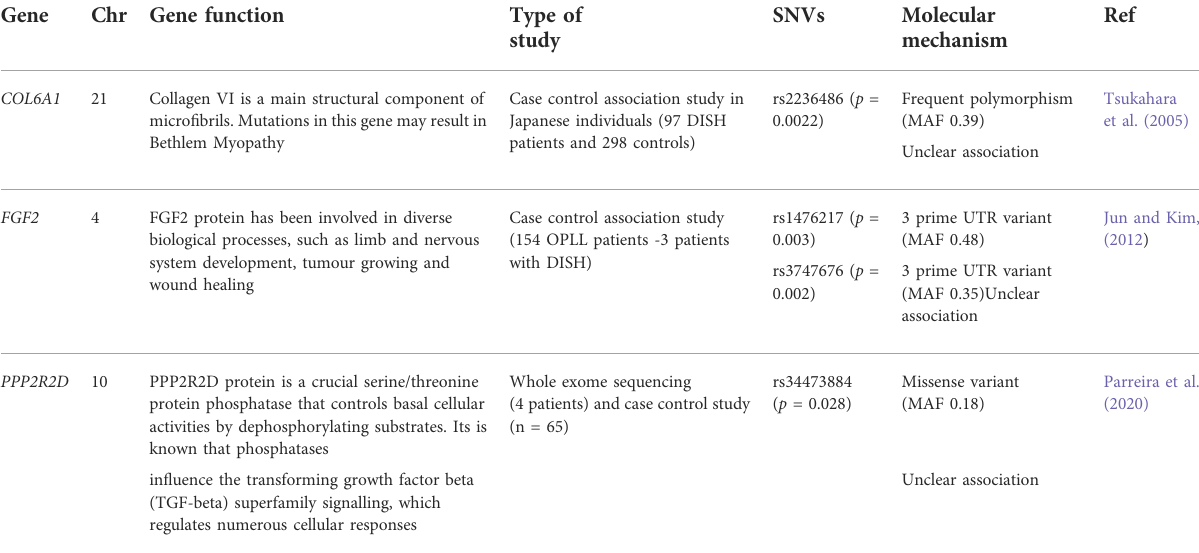
TABLE 2 Genes and genetic variants associated with DISH. The protein physiological function is also mentioned. Gene function was obtained from GeneCards database. Gene Chr Gene